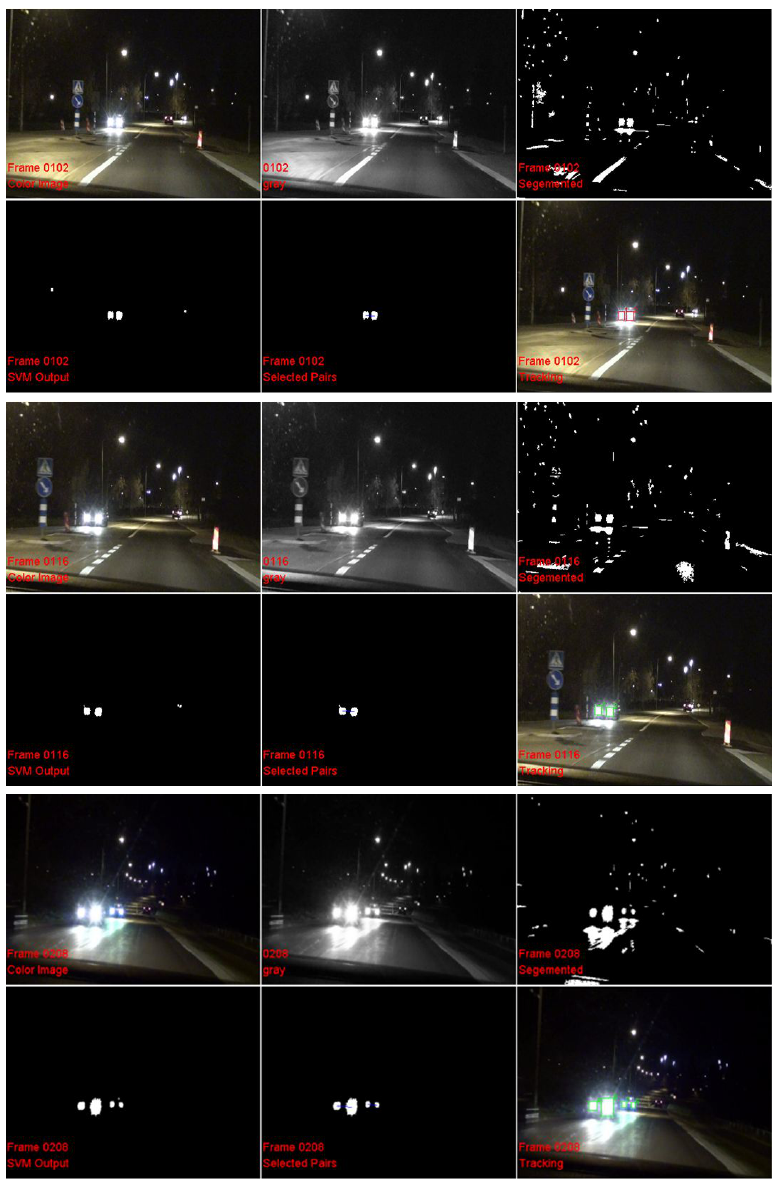
Figure 9. Sample results of multiple vehicle